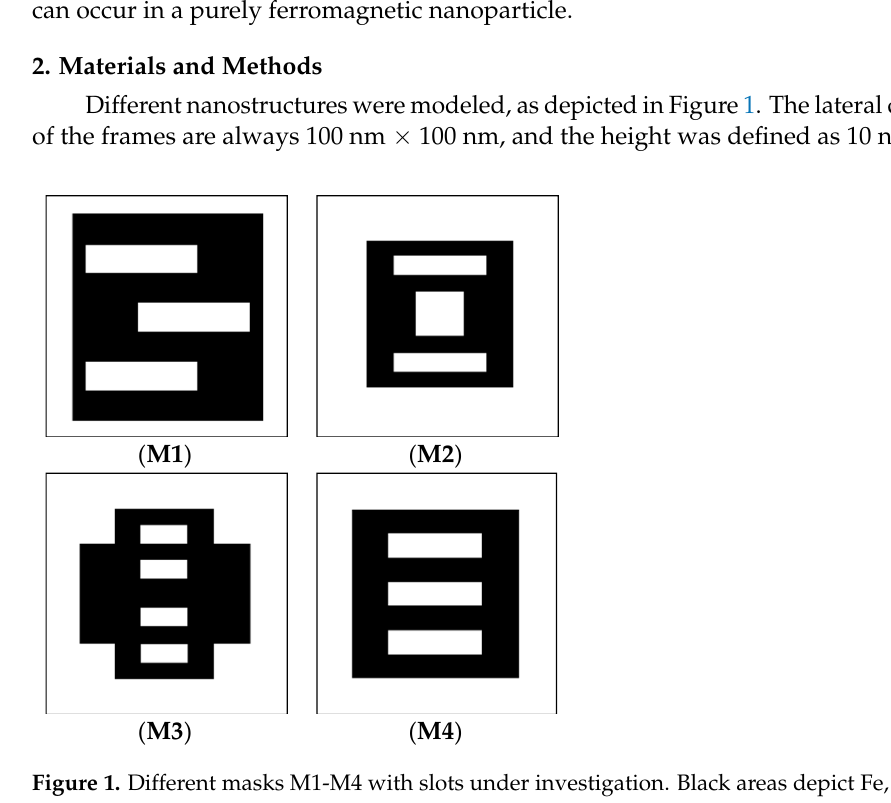
Figure 1. Different masks M1-M4 with slots under investigation. Black areas depict Fe, while white areas are empty—filled with air.